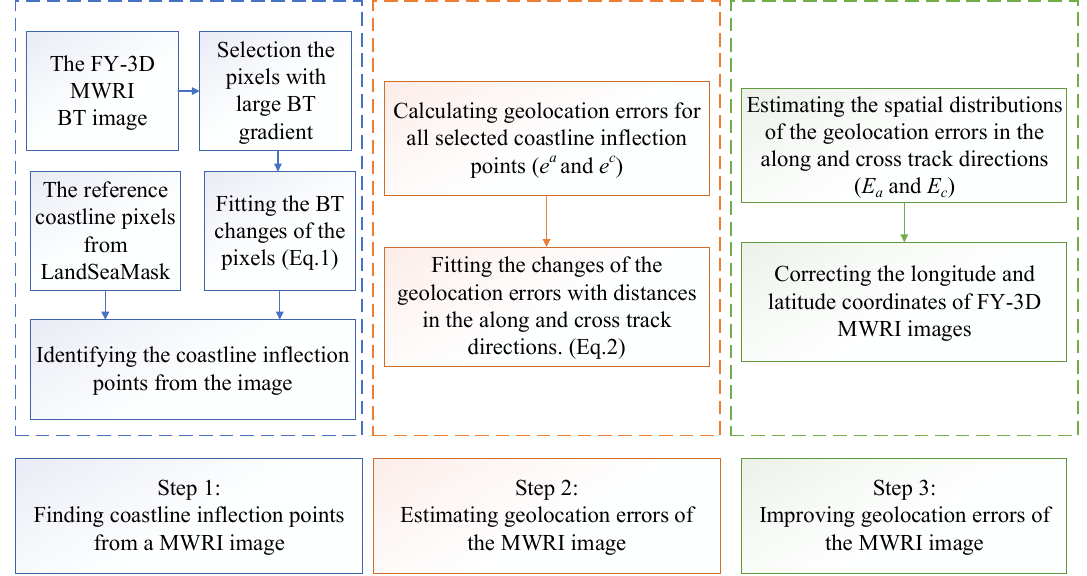
Figure 2. The flowchart of the SCIM geolocation correction for FY-3D MWRI data.